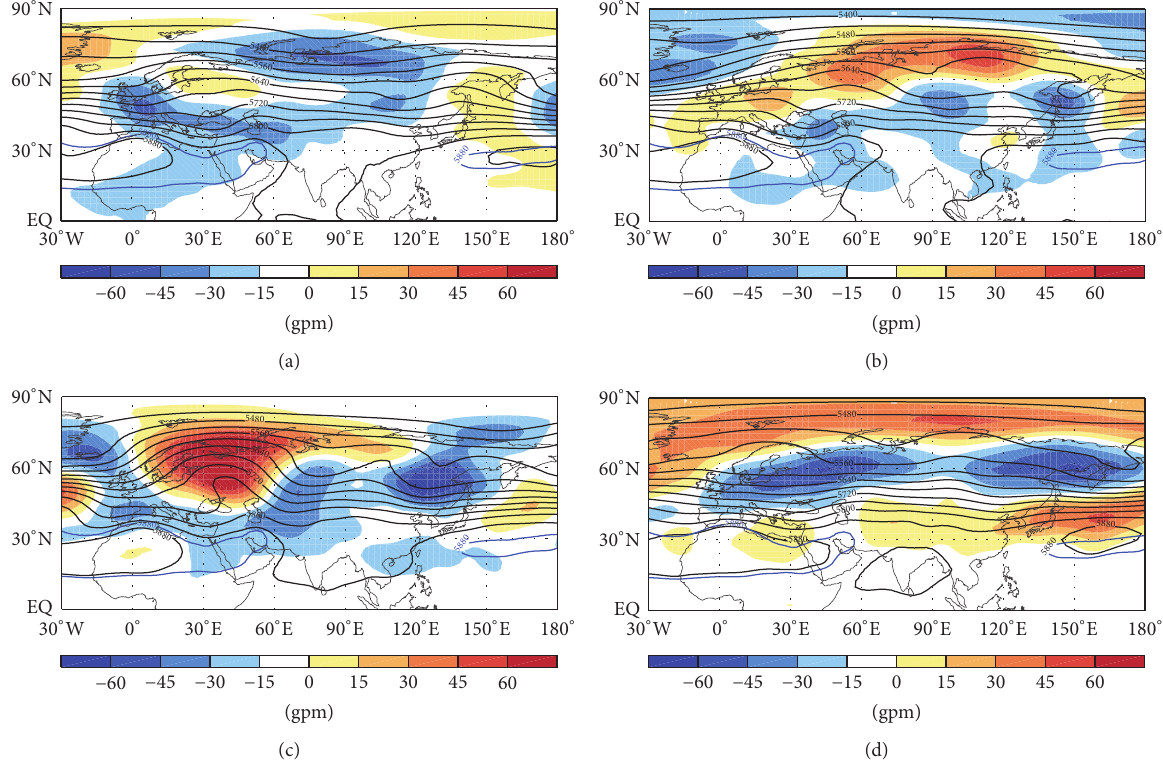
Figure 7: 500 hPa GPH (contour) and its corresponding anomalies (shading) (units: gpm) of the WBWD pattern in the summers of (a) 1966, (b) 1967, (c) 1972, and (d) 1978; blue lines denote the climatology of 5880